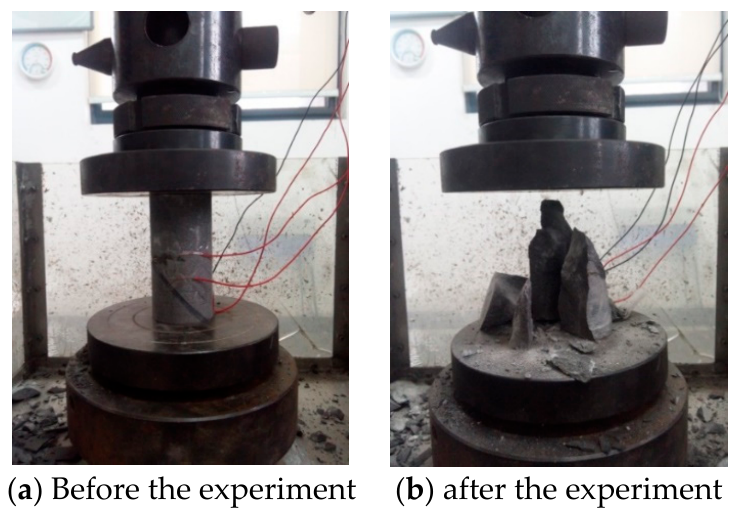
Figure 3. Mudstone sample on the floor of hole No. 3 in the experiment. (2) Uniaxial tensile strength experiments of the specimens were carried out by the splitting method. The diameter and height of the specimens were also measured before the experiment, and after the measurement was completed, each specimen was placed on the tensile jig and loaded until the specimen was damaged. An example of the field experiment is shown in Figure